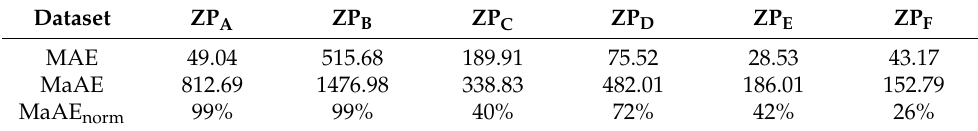
Table 5. Simulation results with the LSTM algorithm for datasets ZP A , . . . , ZP F . Dataset